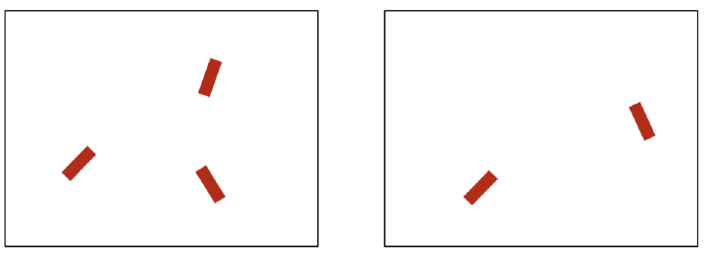
Figure 1a. A size-number congruent trial in the small numerosity condition in Experiment 1.